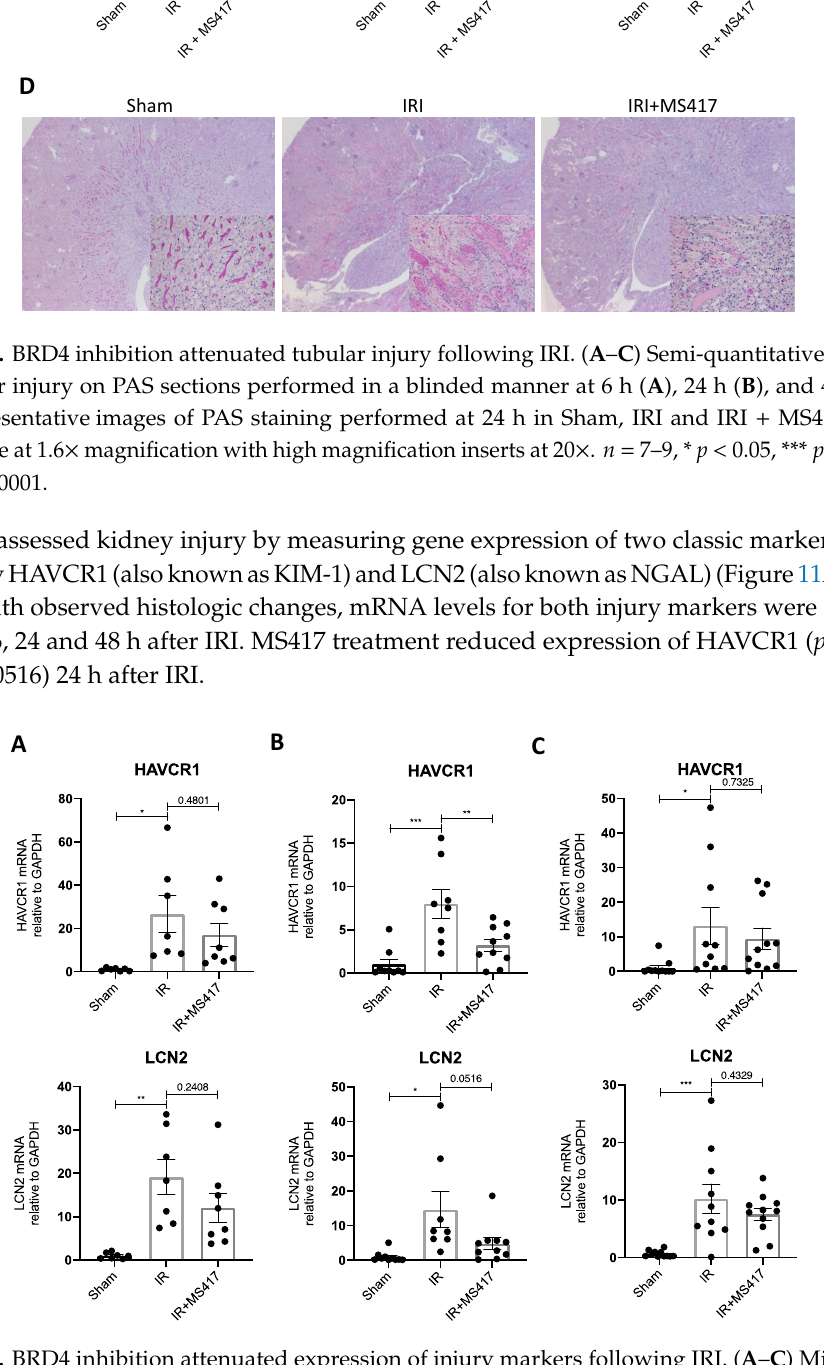
Figure 11. BRD4 inhibition attenuated expression of injury markers following IRI. ( A – C ) Mice were sacrificed at 6 ( A ), 24 ( B ), and 48 h ( C ) and kidney tissue was collected for qPCR analysis of injury markers (HAVCR1 and LCN2). n = 7–11, * p < 0.05, ** p < 0.01, *** p < 0.001.